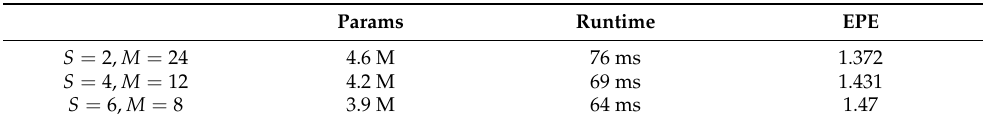
Table 5. Number of parameters, runtime, and EPE of our method for different values of S and M on the Scene Flow test